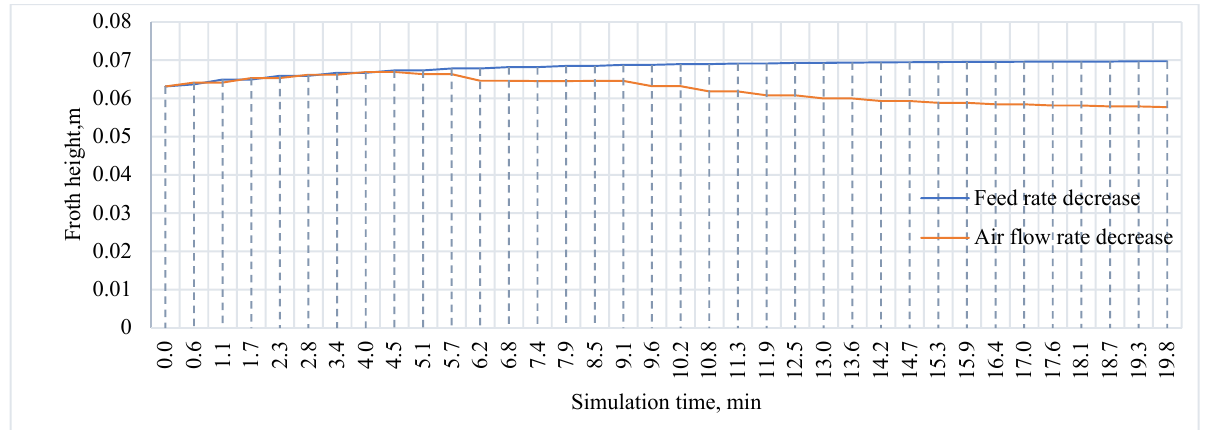
Figure 11. Concentrate mass flow rate values in the simulation.